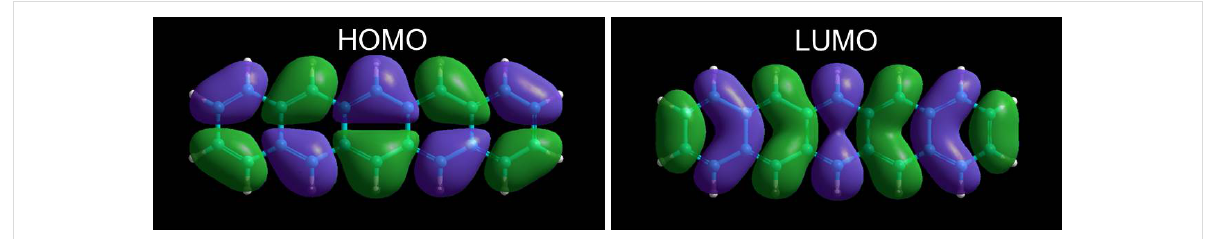
Figure 5: Hückel calculations of the frontier molecular orbitals (HOMO and LUMO) of pentacene in the gas phase superimposed with a ball-and-stick model of the molecular structure.